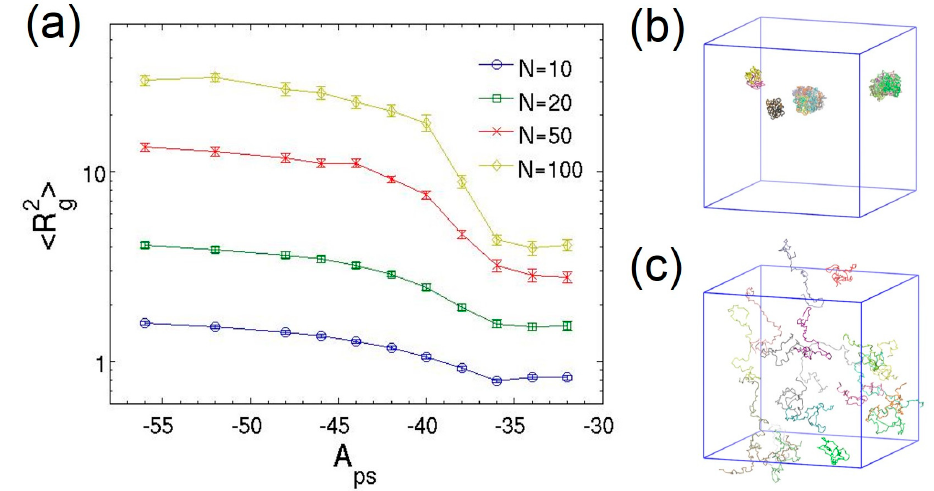
Figure 2. ( a ) Mean-square radius of gyration as a function of solvent quality quantified by A ps for dilute polymer solutions with different chain lengths. Snapshots of dilute polymer solutions with chain length N = 100 in the: ( b ) globule; and ( c ) expanded coil states. Colors represent different chains. The lines are only guides to the eyes. The error bars represent the standard deviations of the ensemble averages.